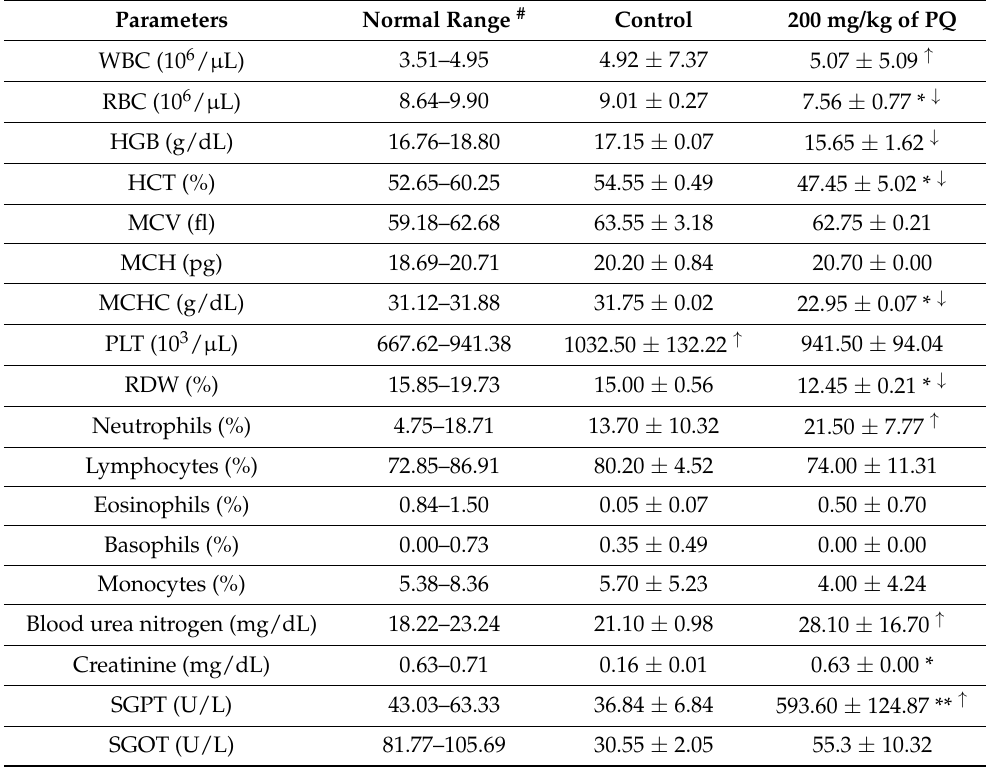
Table 2. Complete blood count and blood clinical chemistry comparing between rats treated with or without PQ; Mean ±